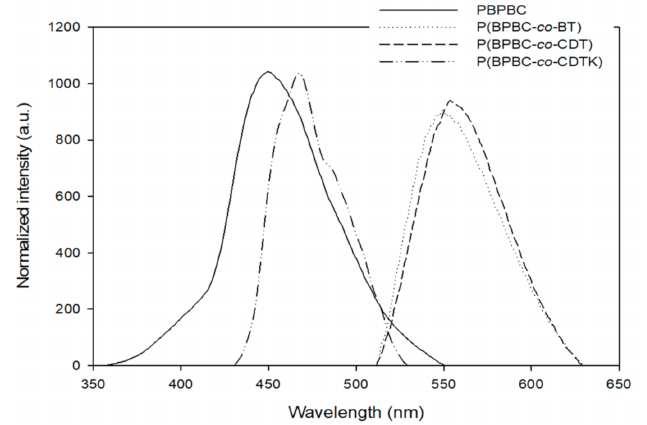
Figure 9. The photoluminescence (PL) spectra of PBPBC ( λ ex = 310 nm), P(BPBC- co -BT) ( λ ex = 400 nm), P(BPBC- co -CDT) ( λ ex = 400 nm), and P(BPBC- co -CDTK) ( λ ex = 310 nm) films.